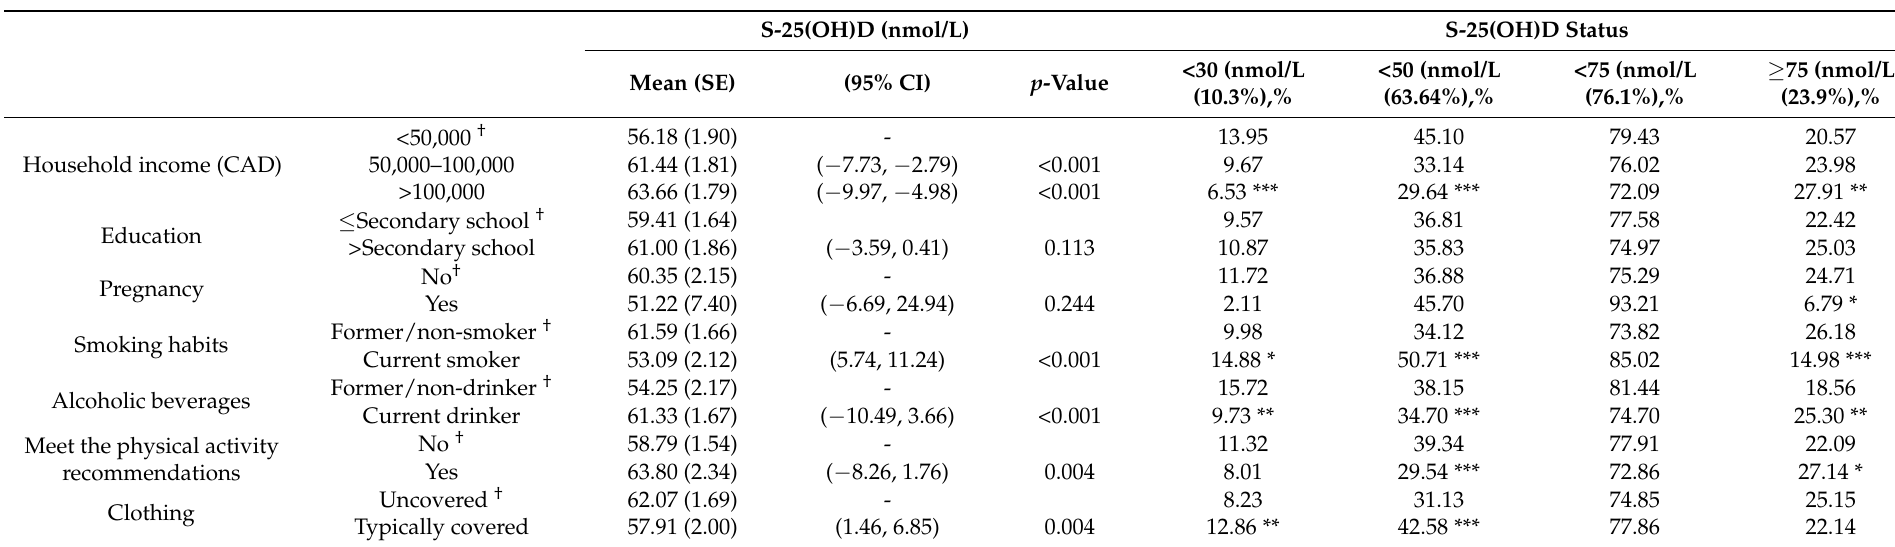
Table A4. Weighted means for S-25(OH)D (nmol/L) and vitamin D status by sociodemographic and lifestyle factors using Cycles 3 and 4 of Canadian Health Measures Survey